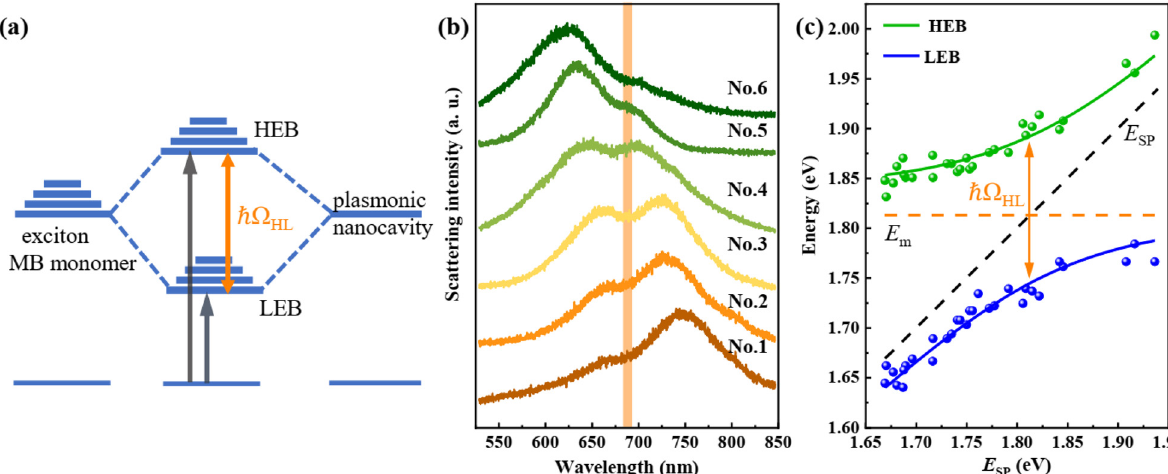
Figure 3: Strong monomer exciton-plasmon coupling. (a) Schematic representation of the strong coupling between the exciton of the monomeric dye molecule (left) and the surface plasmon of nanocavity(right),leadingtotheformationoftwoneweigenhybridlight – matterstates:thehighenergybranch(HEB) andthelowone(LEB).The Rabi splitting energy is marked as ℏ Ω HL . (b) Scattering spectra of the hybrid nanostructures with different Ag nanocube sizes (sample numbers from No. 1 to No. 6). All spectra appear two peaks and a dip at the exciton resonance of MB. SPR wavelength of the plasmonic nanocavity is tailoredacrosstheexcitonresonanceofMB.(c)DispersionofplexcitonwithHEBandLEBvariedasafunctionofplasmonenergy.Greenandblue dotsindicateexperimentaldataextractedfromscatteringspectra.Thesolidlinesare fi ttingresultsbythecoupledharmonicoscillatormodel.The blackdashlinepresentstheplasmonenergyofthepureplasmonicnanocavity,whiletheorangedashlineindicatestheexcitonresonanceofMB. Orange arrow marks the Rabi splitting energy of the hybrid nanostructures, giving a splitting of ℏ Ω HL = 147